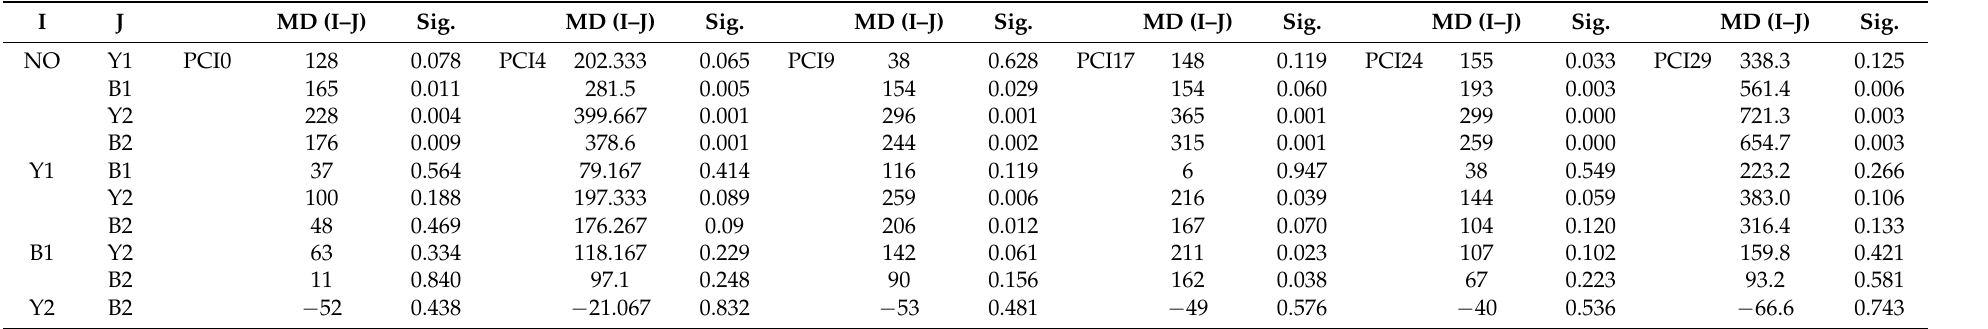
Table A3. Per capita income—post hoc tests—multiple comparisons using